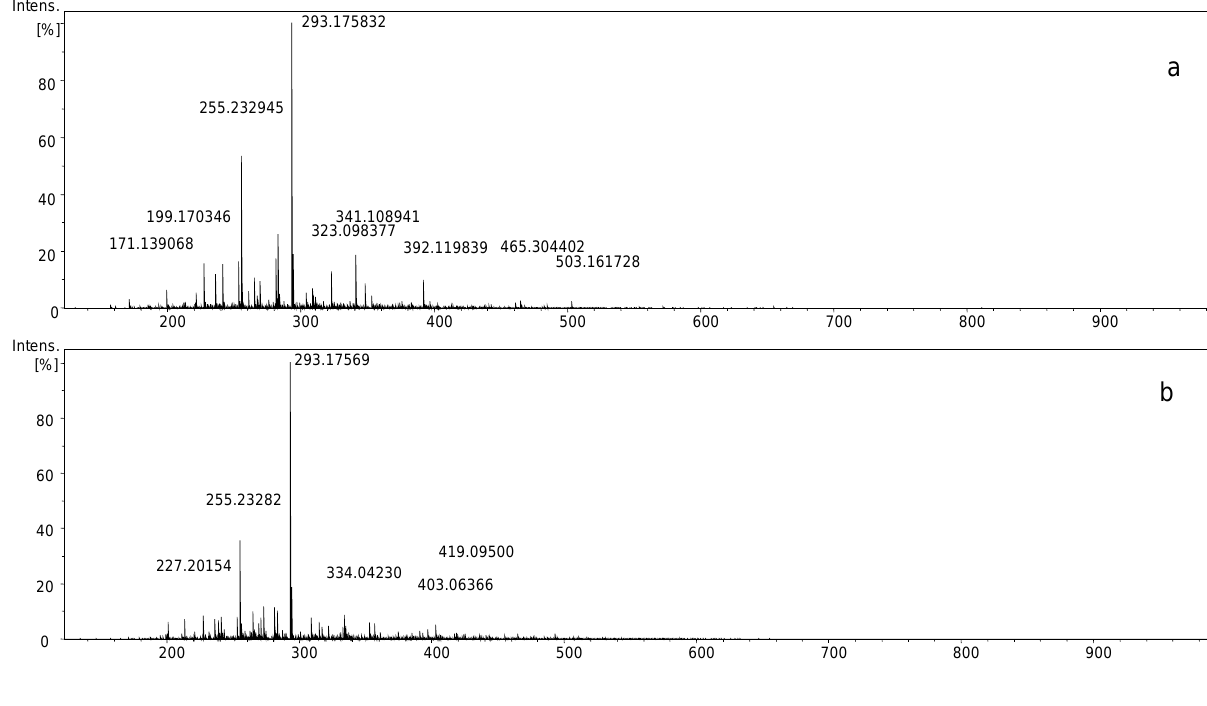
Figure 2. Direct infusion ESI-FT-ICR mass spectrum of a reaction of ( a ) sucrose with serine and ( b ) sucrose with cysteine in negative ion